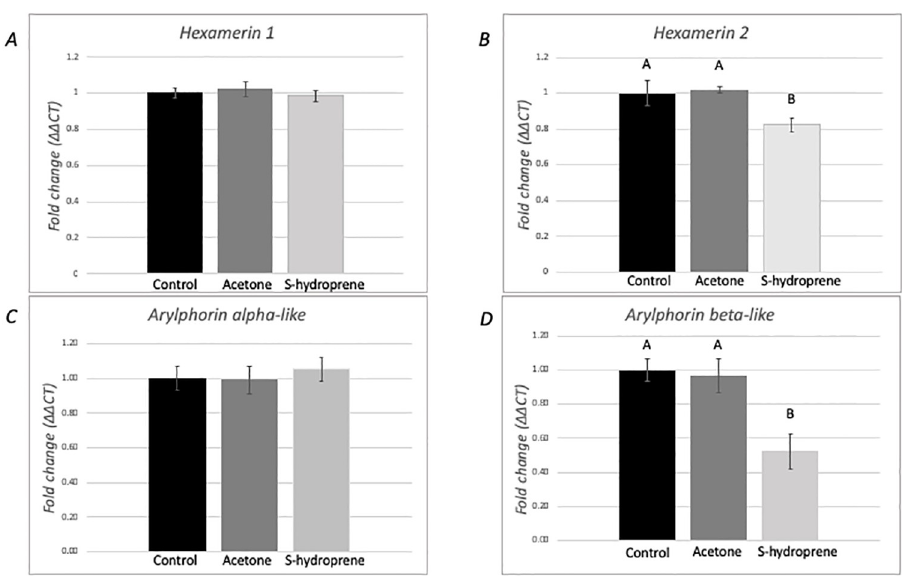
Fig 3. Expression analysis of hexamerin transcripts in medium-sized foragers 12 h following topical application of S-hydroprene. Relative expression of (A) hexamerin 1 , (B) hexamerin 2 , (C) arylphorin subunit alpha-like , and (D) arylphorin subunit beta transcripts. Gene expression was quantified using RT-qPCR and analyzed using the ΔΔ Ct method. For each gene, mRNA expression level was normalized relative to rp18 . Bars represents mean ± SEM fold change relative to the untreated control ( n = 6). Statistical relationships between groups were assessed using one-way ANOVA. Significant differences in gene expression ( p < 0.05) were determined for hexamerin 2 and arylphorin subunit beta . For those genes, different letters indicate significant differences in gene expression as determined with Tukey post hoc analyses.